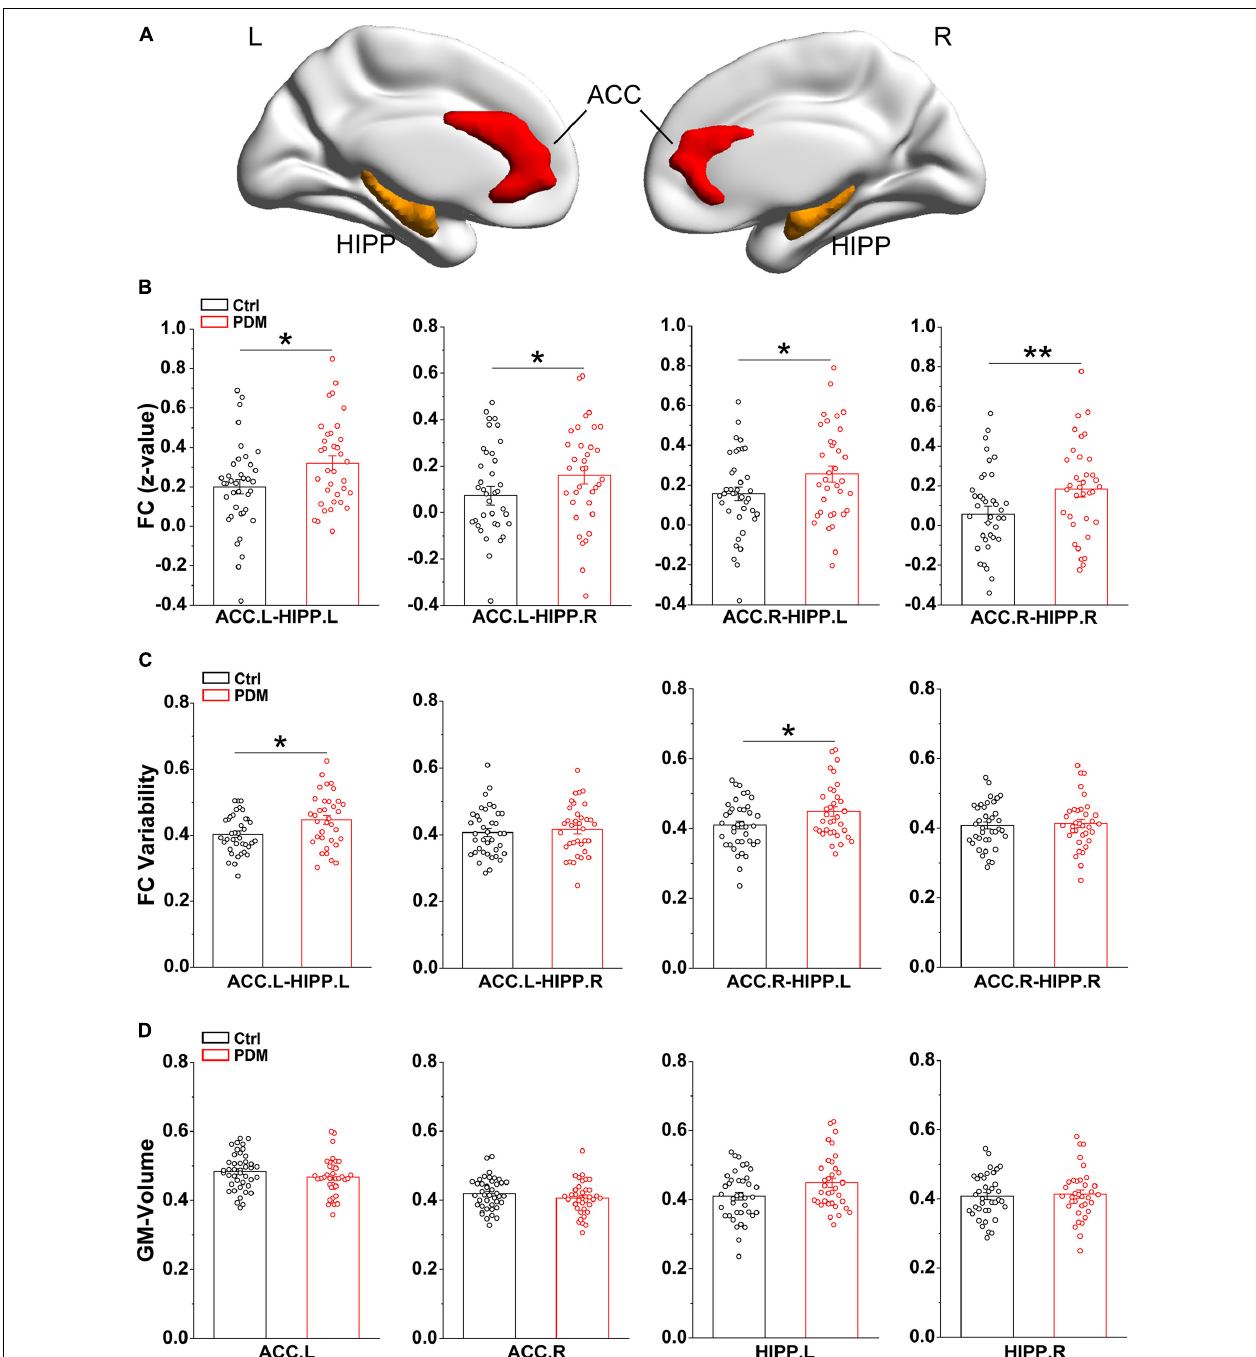
FIGURE 1 | Greater static FC and FC variability between ACC and HIPP, with unchanged GM volumes, in PDM females. (A) Three-dimensional brain view of the ICBM152 MNI depicting the location of the bilateral ACC (red) and HIPP (yellow) based on the Anatomical Automatic Labeling (AAL) atlas. (B) In the static FC, PDM subjects exhibited increased FC between ACC.L-HIPP.L, ACC.L-HIPP.R, ACC.R-HIPP.L, and ACC.R-HIPP.R. (C) The PDM group exhibited significantly greater FC variability between ACC.L-HIPP.L and ACC.R-HIPP.L than controls. (D) The GM volume of both ACC and HIPP did not change significantly in PDM females compared to controls ( p > 0.05). L, left hemisphere; R, right hemisphere. Error bars = ± 1 SE. n = 35 (38) and 38 (42) for PDM and control females in the static FC, FC variability (GM volume) analysis, respectively. Non-parametric permutation test with days of menstrual cycle as regressor for static FC, FC variability and GM volume. ∗ p < 0.05; ** p <